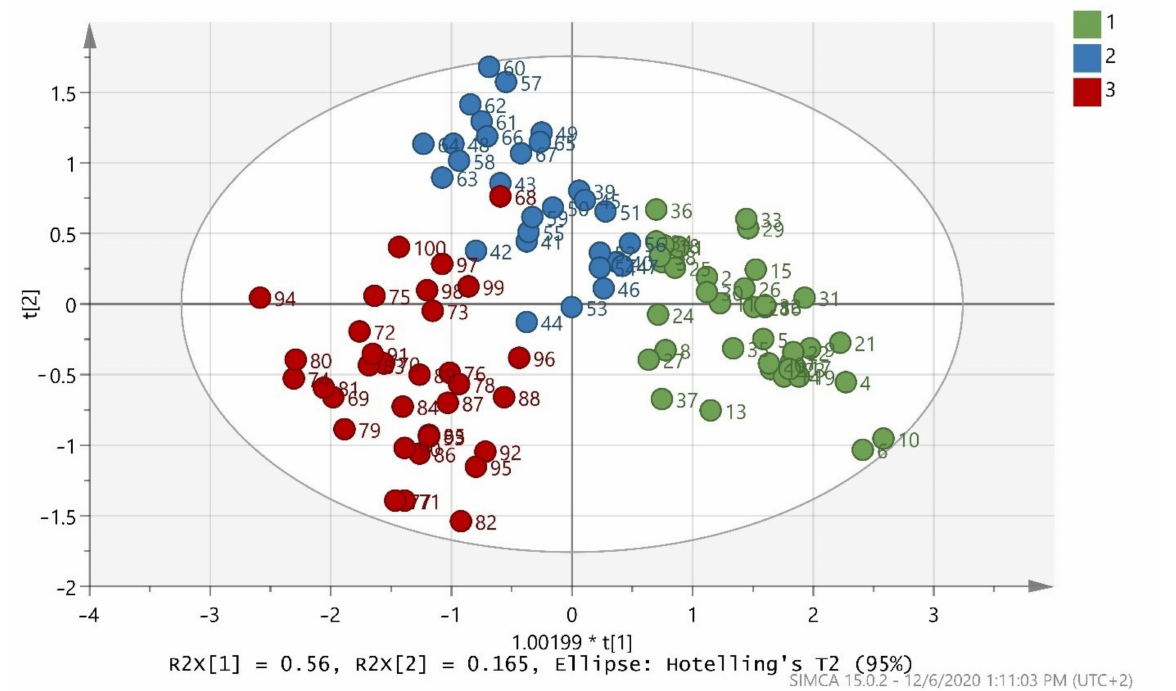
Figure 3. Score scatter plot (t2/t1) from OPLS-DA modeling of the overall model (whole database) where 1 = Maurolia (Messinia), 2 = Lianolia Kerkyras (Preveza), and 3 = Koroneiki (Preveza). A = 2 + 1 + 0 components, R 2 X(cum) = 0.999,